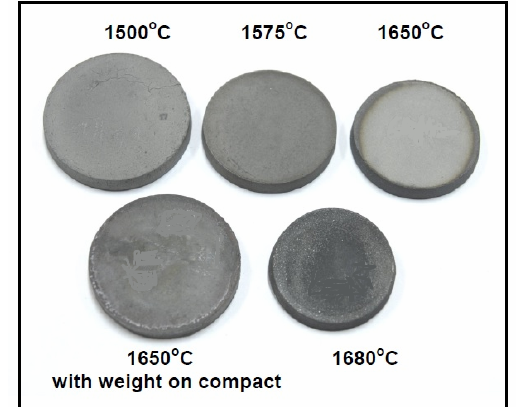
Fig. 3 Appearance of 2.0 composite after PLRS at different temperatures.